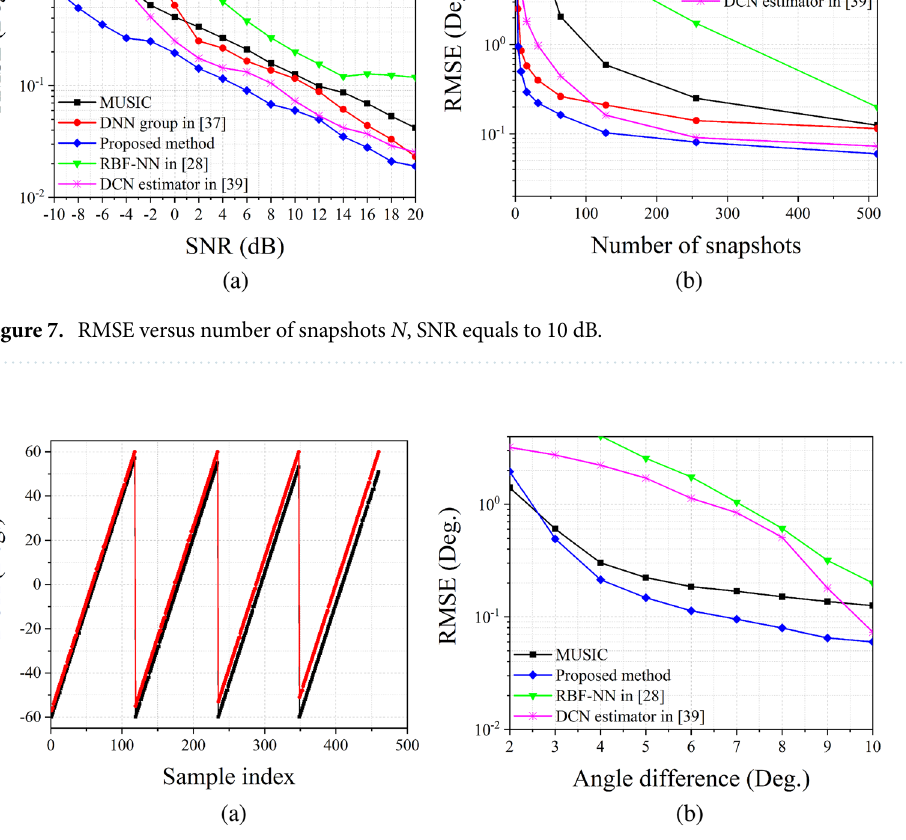
Figure 8. RMSE versus angle difference �θ , SNR equals to 10 dB and number of snapshots N = 512